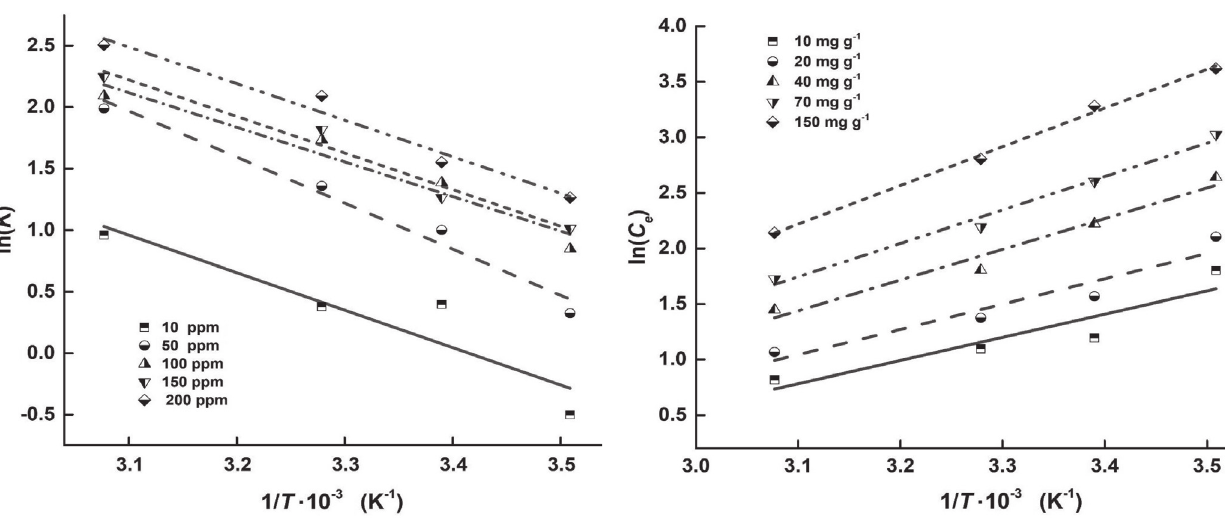
Fig. 8 – Plot of ln(K) against 1/T for evaluation of thermody- namic parameters (25 mg Co-MOF, temperature (K): 325, 305, 295, and 285) Table 4 – Thermodynamics parameters for humic acid adsorption onto Co-MOF HA concentration (mg L –1